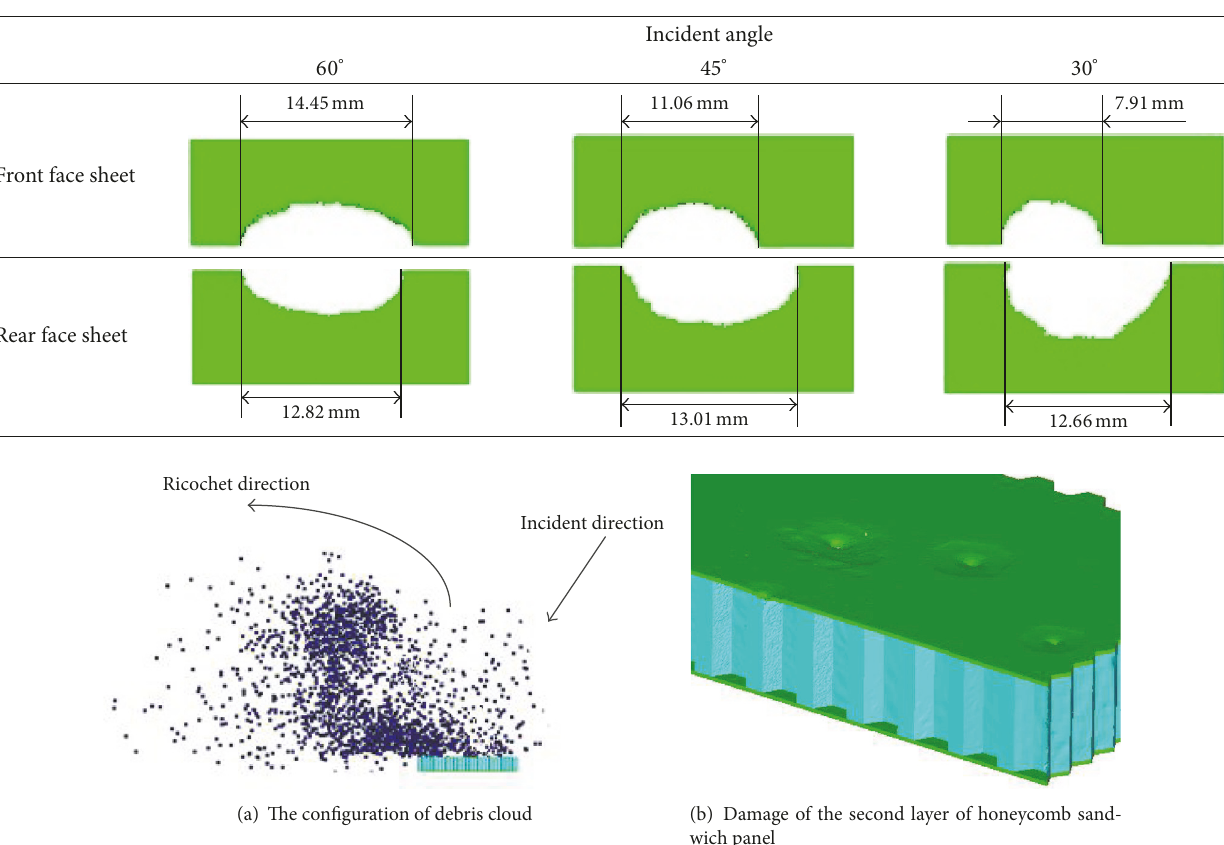
Table 5: The perforation shape of panel.